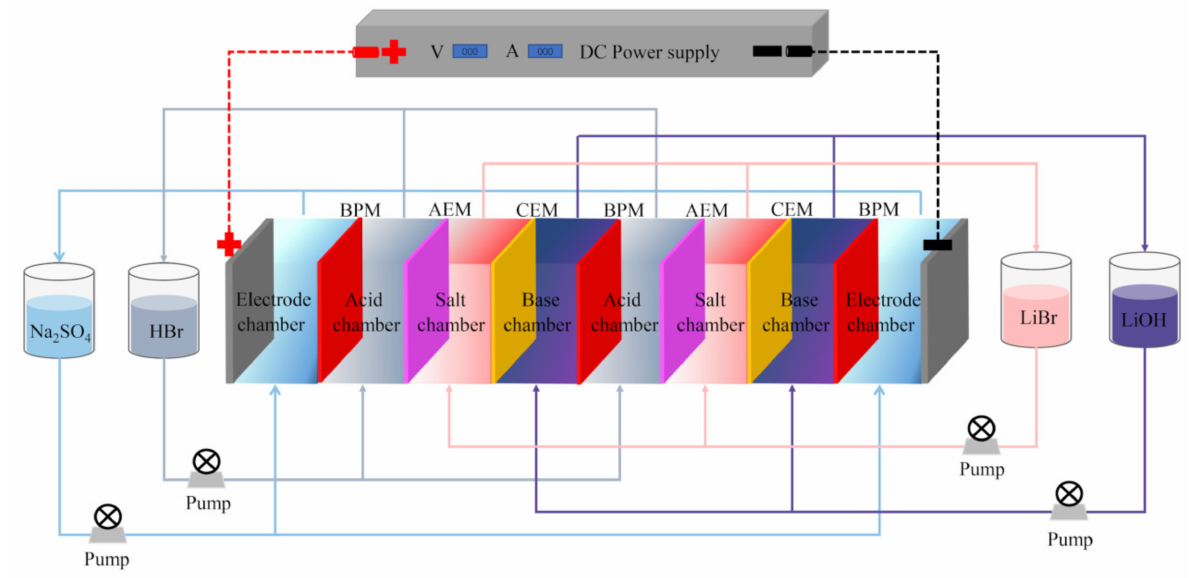
Figure 1. Schematic representation of experimental equipment.